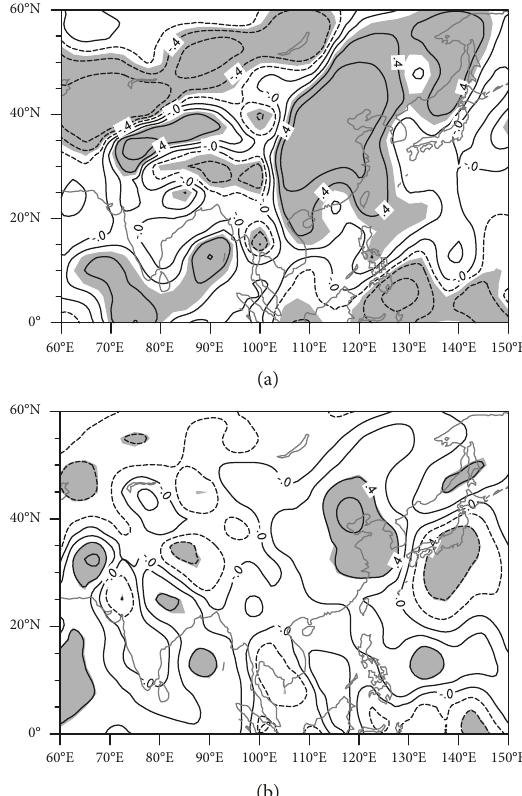
Figure 3: Spatial distribution of correlation coefficient between the APOI and 850hPa meridional wind during (a) 1948–1990 and (b) 1991–2016. The shaded area indicates significant correlation at the 95% confidence level based on Student’s t -test.